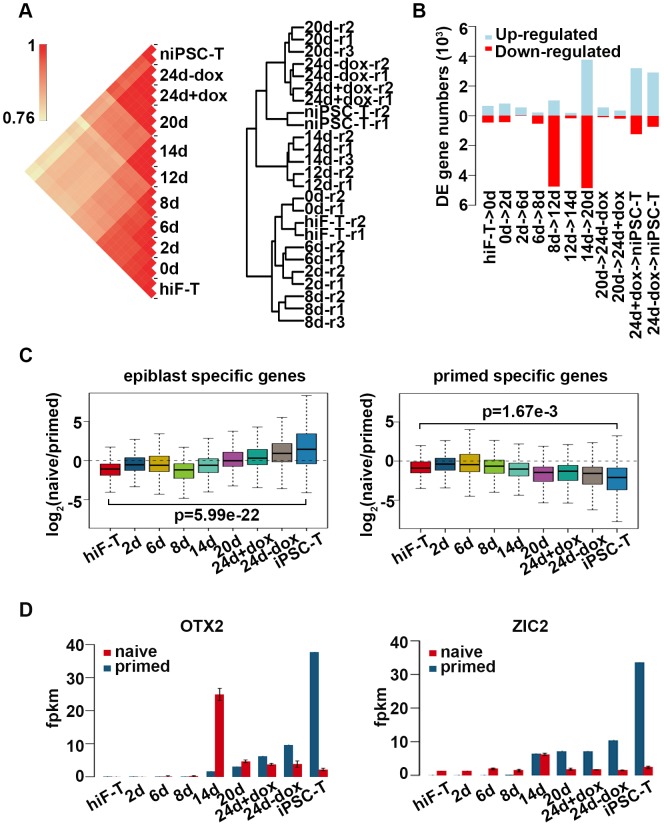
Transcriptional profiling of naïve pluripotency reprogramming cells.(A) Correlation analysis (left panel) ad cell clustering analysis (right panel) of transcriptional profiles at different time points during naïve reprograming. (B) Bar plot showing dynamic changes in differentially expressed (DE) gene numbers of two adjacent time points during naïve reprogramming. (C) Expression dynamics of epiblast-specific genes and primed-specific genes during naïve reprogramming relative to those in the primed reprogramming process. (D) Bar plot showing the absolute expression values of OTX2 and ZIC2 genes in the naïve and primed reprogramming processes. Error bars represent a 95% confidence interval around the mean value.